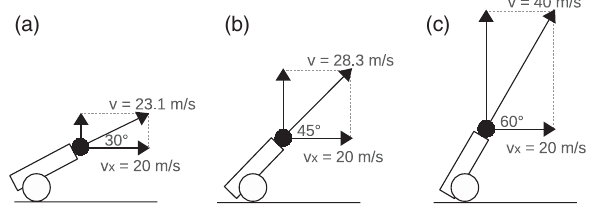
FIG. 7. Pictures from one of the problems labeled with upward-pointing triangles ( 4 ) in Fig. 4. The horizontal compo- nent of the initial velocity is always 20 m = s in this problem. The problem is adapted from Ref.